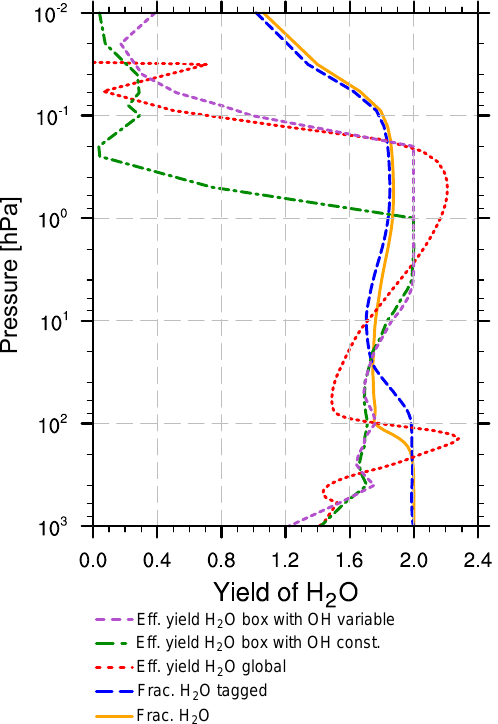
Figure 13. H portion of tagged and total H 2 O with respect to the tagged and total hydrogen content H y = ( H + 2 · H 2 + 2 · H 2 O ) , respectively, i.e., 2 · H 2 O / H y (orange solid) and 2 · H 2 O tagged / H y (blue dashed). tagged